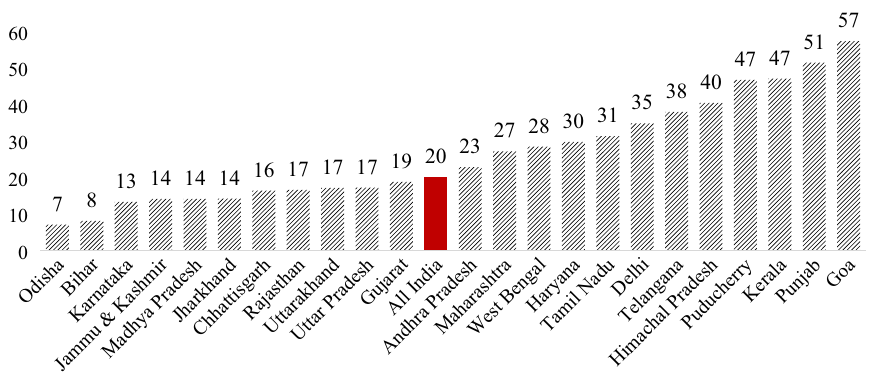
Fig. 1 Percentage of children (3–5 years) attending pre-primary education by major states. Source: Authors’ estimation from 75th NSO round data,